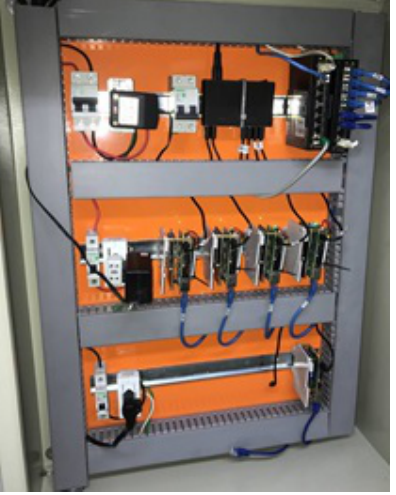
Figure 15. Supervisory system hardware